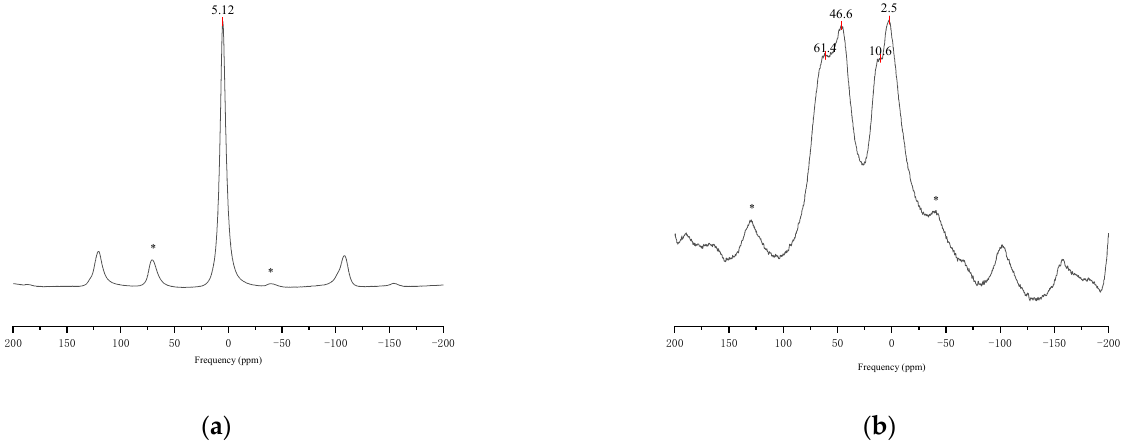
Figure 8. 27 Al NMR of ordinary kaolin ( a ) and metakaolin ( b ). * indicates rotational bands.